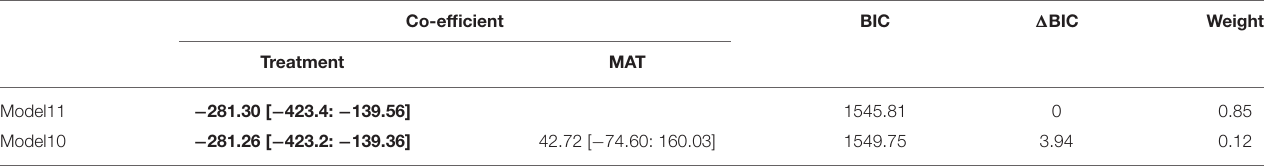
TABLE 4b | Mixed linear model outputs showing the top two models, selected using BIC values for S. nigrescens .